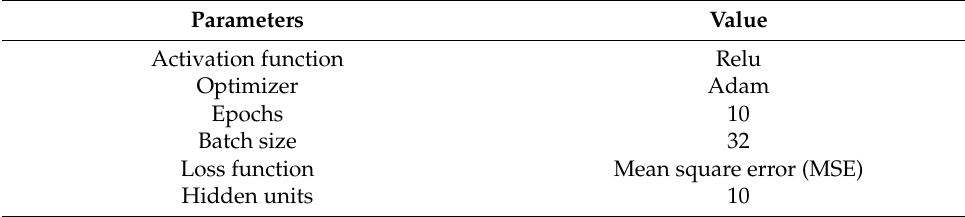
Figure 2. The BP network structure diagram. Table 1. The parameters of the BP